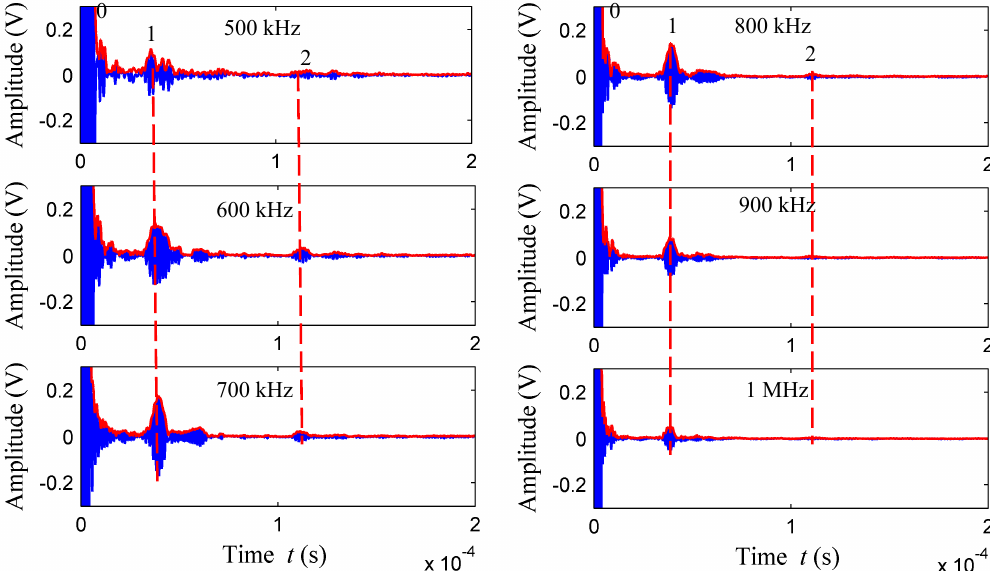
Figure 16. The time domain waveforms for crack defects of pipe inner wall.